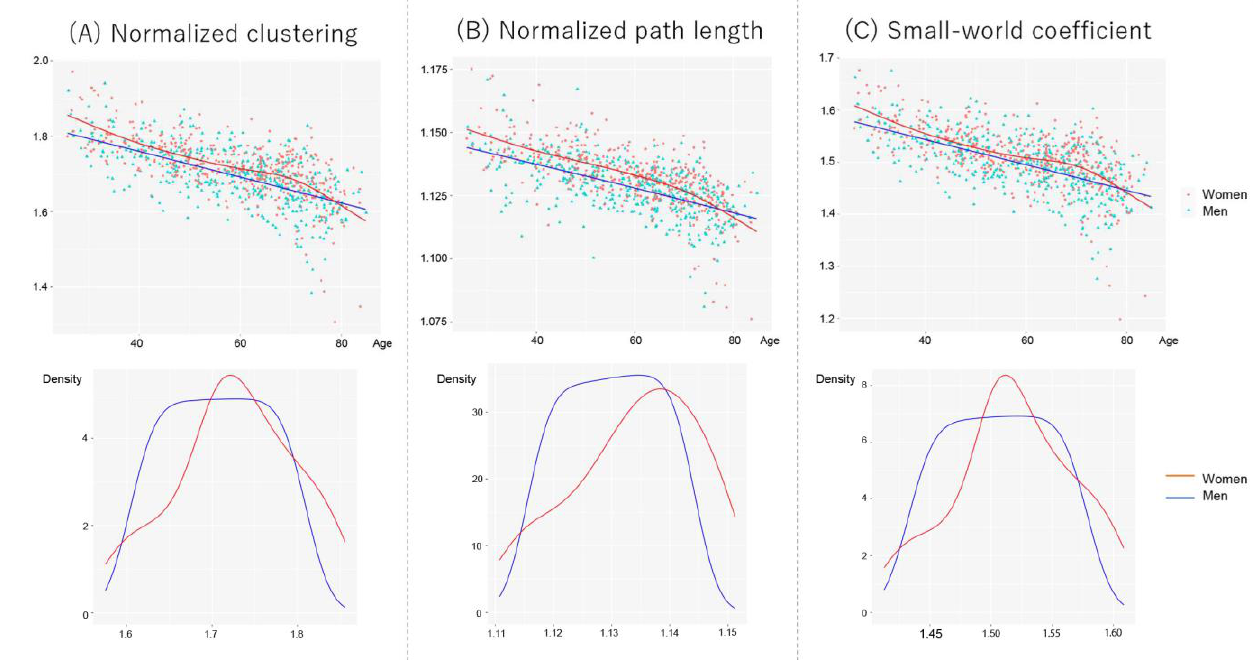
Figure 4. Scatter plots and fit curves of the global network properties for women and men. The fit curves were constructed based on the generalized additive model (GAM). ( A ) Normalized clustering, ( B ) normalized path length, and ( C ) small-world coefficient. Each data distribution for women and men was shown using a kernel approximation.